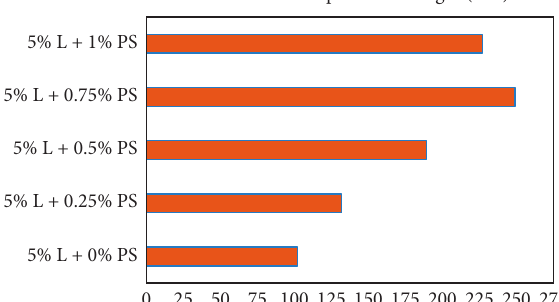
Figure 3: Variation in maximum dry density with plastic strips.